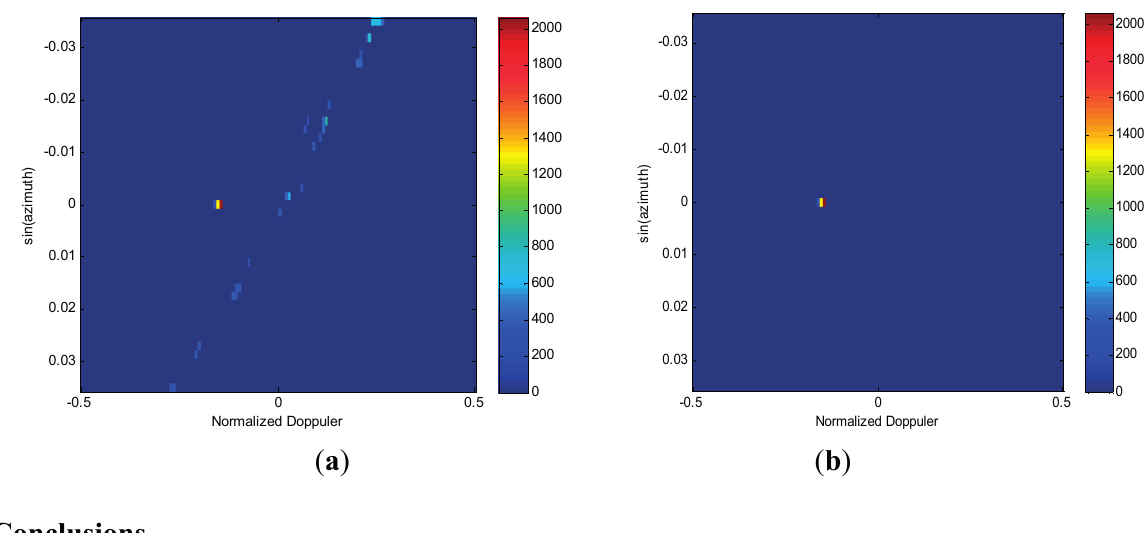
Figure 8. Performance assessment using the three-channel SAR/GMTI real data. ( a ) 2D RDSR spectrum estimation. ( b ) Moving target